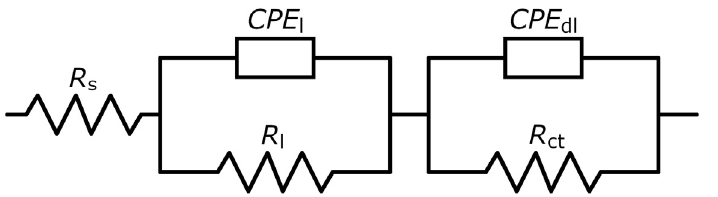
Figure 6. The electrical equivalent circuit used to describe oxygen evolution reaction on CoFe 2 O 4 electrodes.